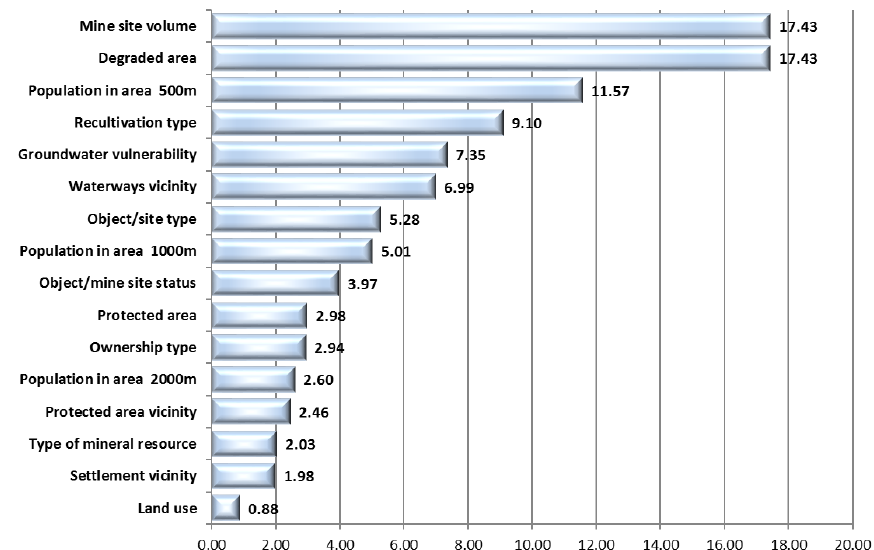
Figure 7. The impact of individual criteria in the total assessment.